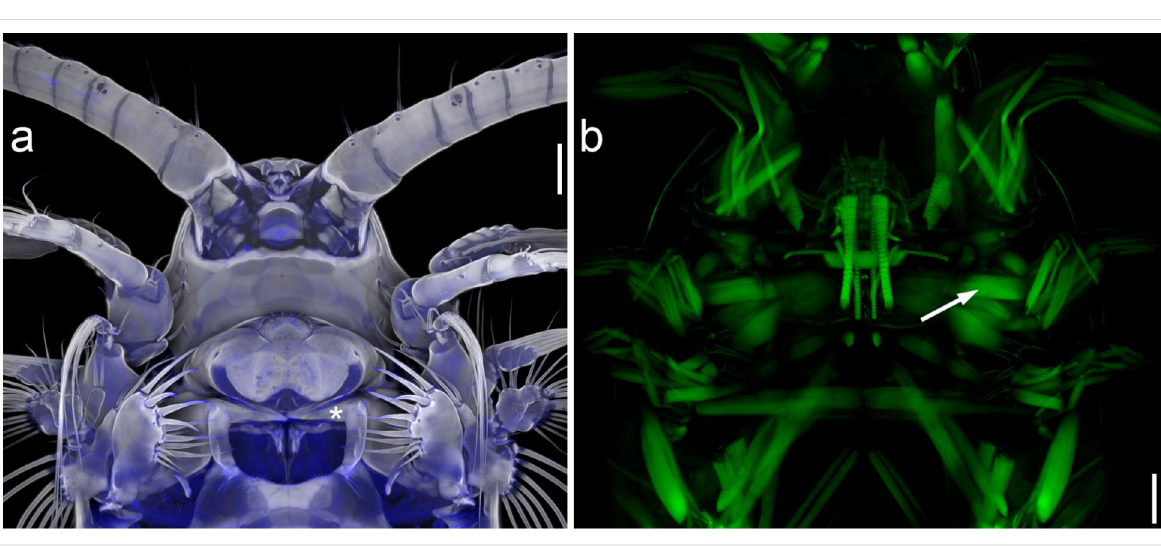
Figure 7: Muscular system of the anterior part of Centropages hamatus . Confocal laser scanning micrographs (maximum intensity projections) showing ventral views of the exoskeleton (a) and the muscles (b) of female C. hamatus . Please note that the two micrographs show different sections of two different copepod specimens. The asterisk and the arrow indicate the positions of the left gnathobase and the strong muscles of the left mandible, respectively. Scale bars = 50 µm. Figure reproduced with permission from [10]. Copyright 2014 Wiley-VCH Verlag GmbH & Co